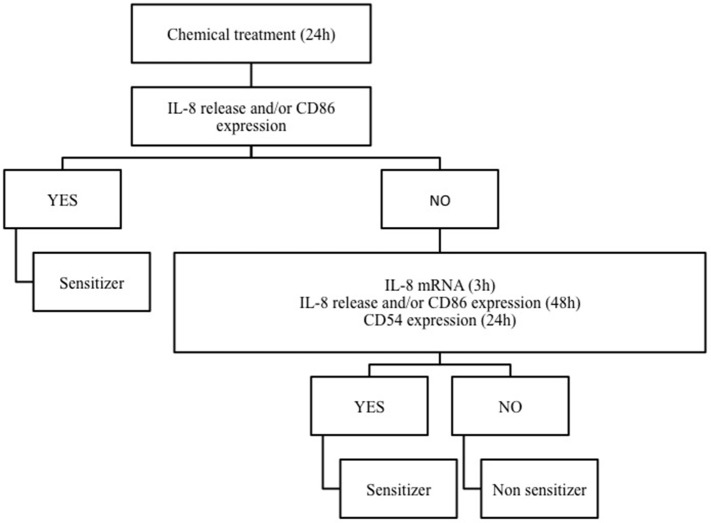
The THP-1 activation assay tier approach. Following 24 h of THP-1 chemical/drug treatment, the effect on IL-8 release and CD86 expression are investigated. If positive (statistically significant release of IL-8 at any concentration and/or a SI ≥ 1.5 for CD86), the chemical/drug will be considered as sensitizer. If negative, in order to exclude any activation, IL-8 release and CD86 expression at 48 h (statistically significant release of IL-8 at any concentration and/or a SI ≥ 1.5 for CD86) or CD54 expression at 24 h (SI ≥ 2.0) or alternatively IL-8 mRNA expression (2−ΔΔCT > 3.0) at 3 h should be assessed. Only if negative results were obtained in all parameters, the chemical/drug will be considered as non-sensitizer.